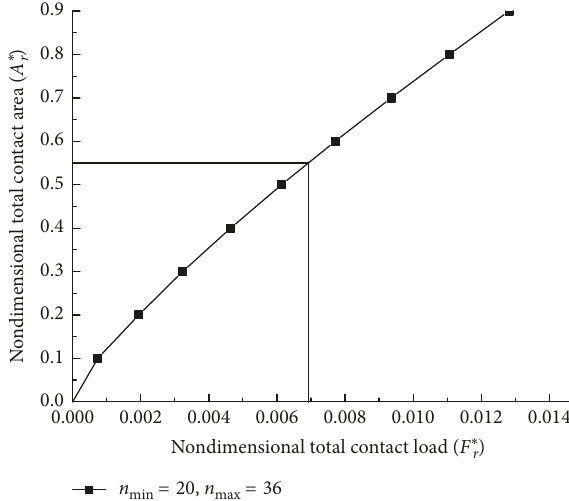
Figure 10: The relationship between dimensionless total real contact area and the dimensionless total contact loading for 20 ≤ n ≤ 36. the deformation characteristics of the asperity under different frequency exponents are obtained.